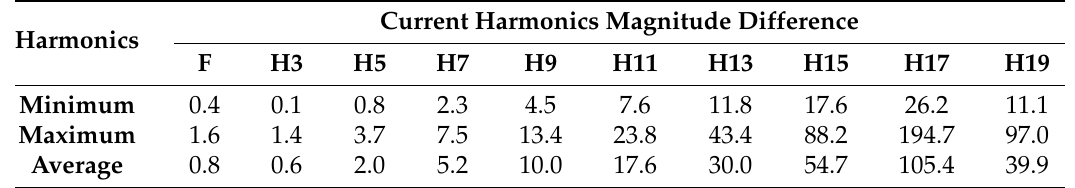
Table 3. Difference between cold and stable state current harmonics magnitude for type 2 SMPSs (%).